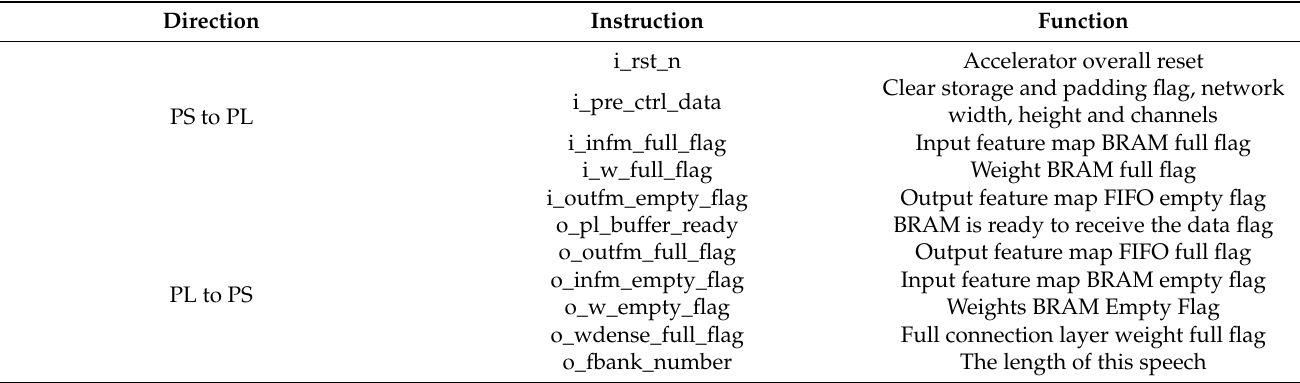
Table 4. Configurable Control Instruction Interpretation.